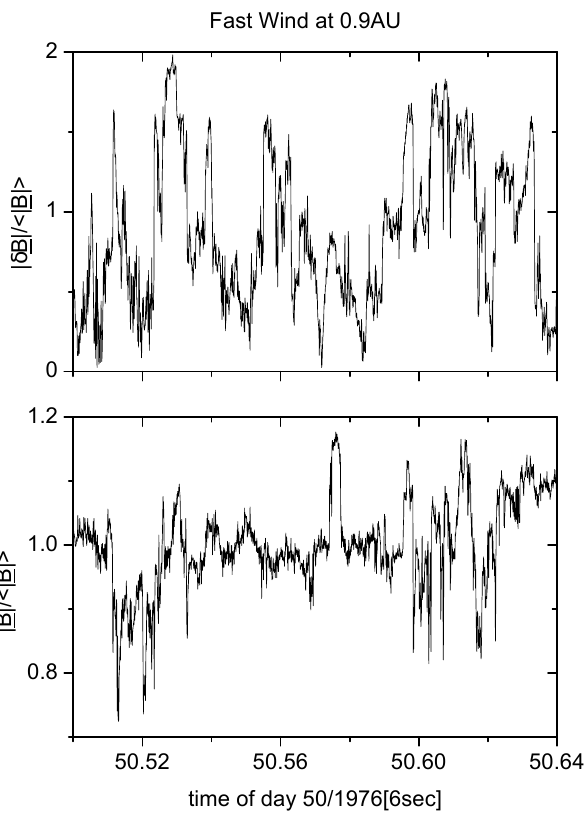
Fig. 8. PDFs of vector displacements | δB | normalized to σ at 0.3 and 0.9AU, for a fast wind, are shown in the top and bottom panels, respectively. The two thin solid curves refer to as many lognormals contributing to form the thick solid curve which best fit the distri- bution. Parameters relative to the fit are reported in Table